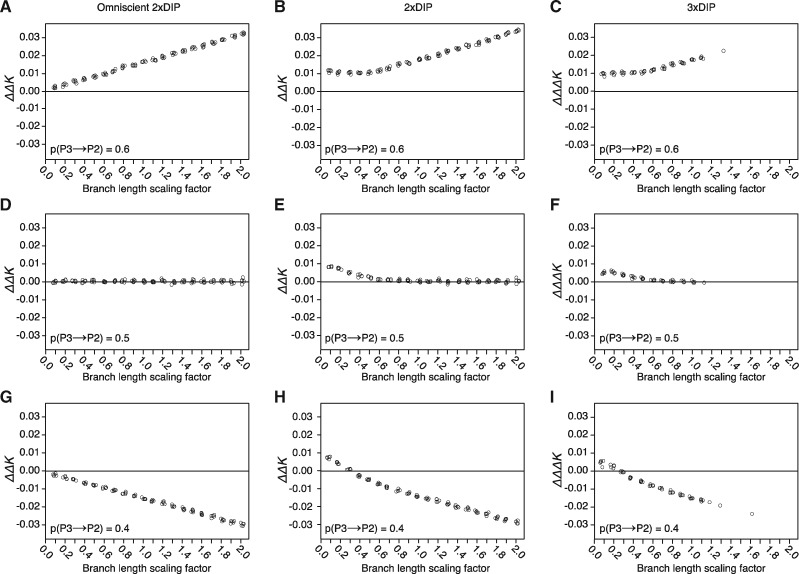
—Exploration of branch length parameters used during genome simulation. The default branch lengths used during all previous simulations (TIG=1, Tα=4, Tβ=8, and Tγ=12) were multiplied by branch-length scaling factors. For all plots, five replicate genomes were simulated for each scaling factor value. pINT = 0.5 was used for all simulations. DIP was performed on each replicate; individual points on plots represent point estimates of ΔΔK and ΔΔΔK (jittered for clarity). Genomes were simulated with asymmetric introgression favoring P3⇒P2 (A–C), symmetric bidirectional introgression (D–F), and asymmetric introgression favoring P2⇒P3 (G–I). Omniscient 2×DIP (A, D, and G), standard 2×DIP (B, E, and H), and 3×DIP (C, F, and I) were performed. ΔΔΔK data points are absent at higher scaling factors because this adjusted version of ΔΔK can only be calculated when there are at least some loci with the unexpected topology (ALT loci) as a result of topology misclassification or ILS.